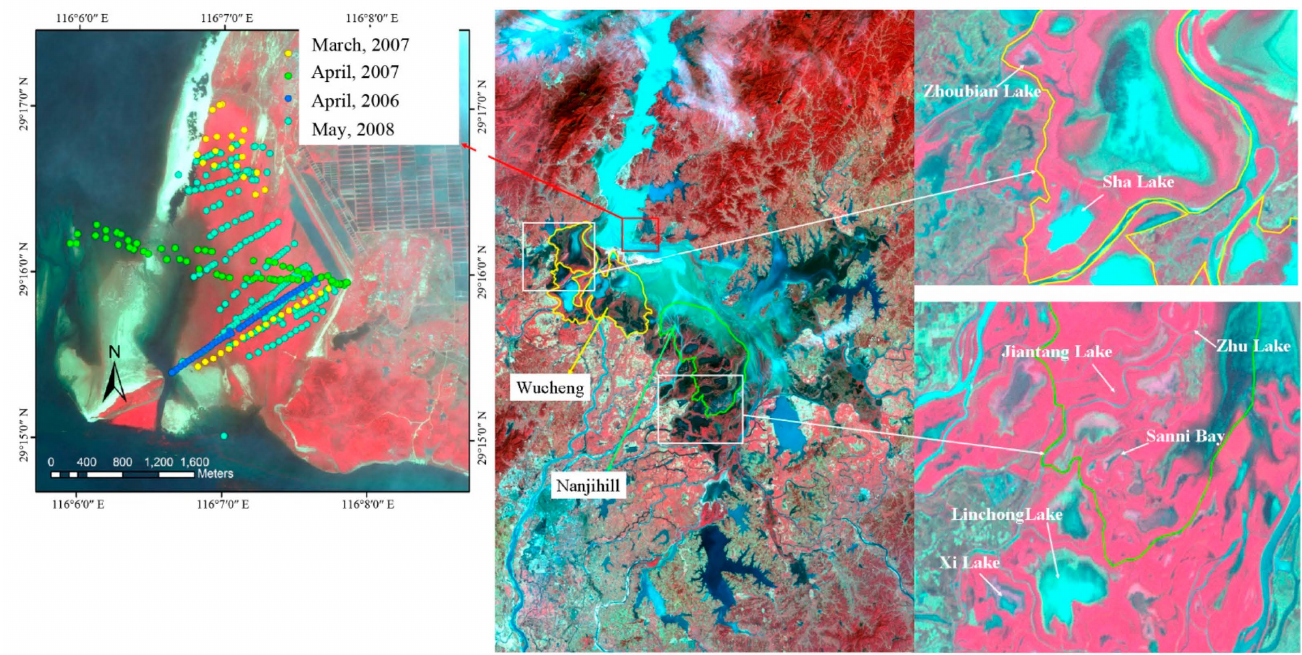
Figure 4. Example of sample validation locations from field visits in May 2009 and revisited field sample locations from 2006 to